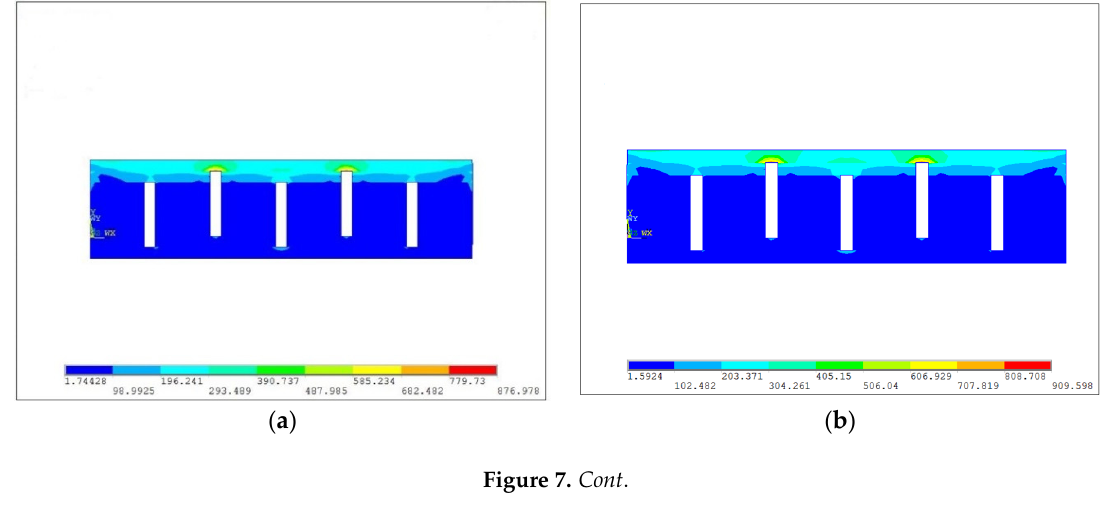
Figure 7. Cont. Figure 7. Cont.